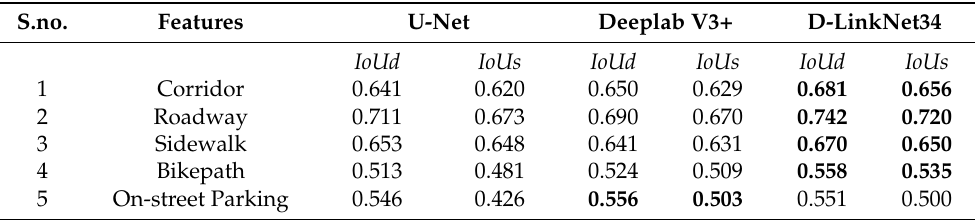
Table 2. Evaluation metrics (IoU) of five street-based features. Values in bold indicate best performing